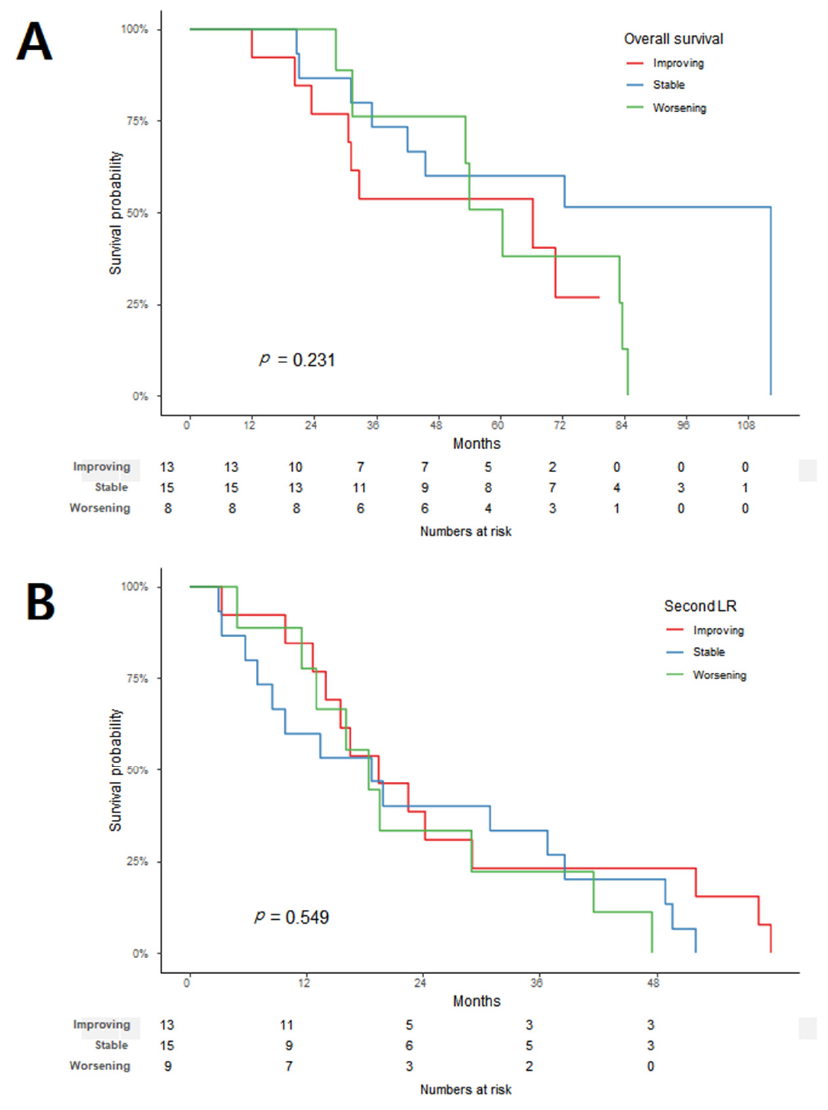
Figure 3. In liposarcoma, Kaplan–Meier survival graph for each group of improving, stable, and worsening according to the change in tumor grade: ( A ) overall survival and ( B ) second local recur ‐ rence.